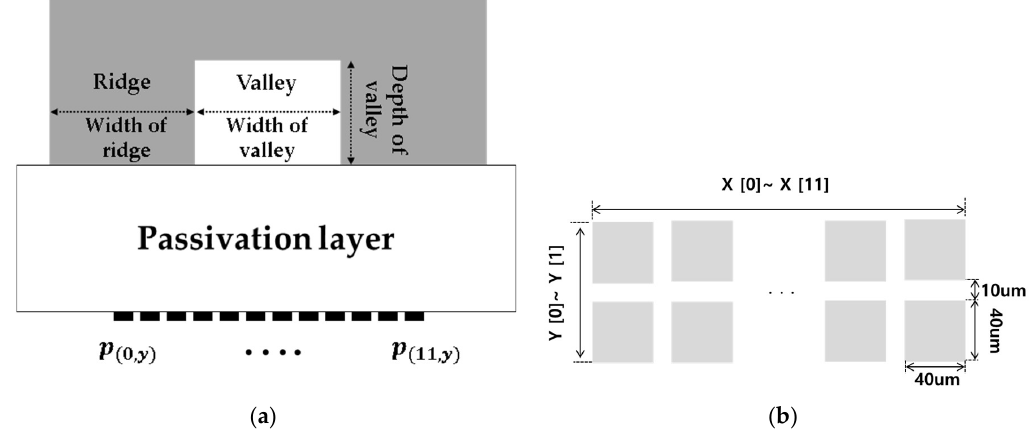
Figure 5. Modeling of a fingerprint, the passivation layer and the array of pixels: ( a ) Cross-sectional view; ( b ) Array of pixels.